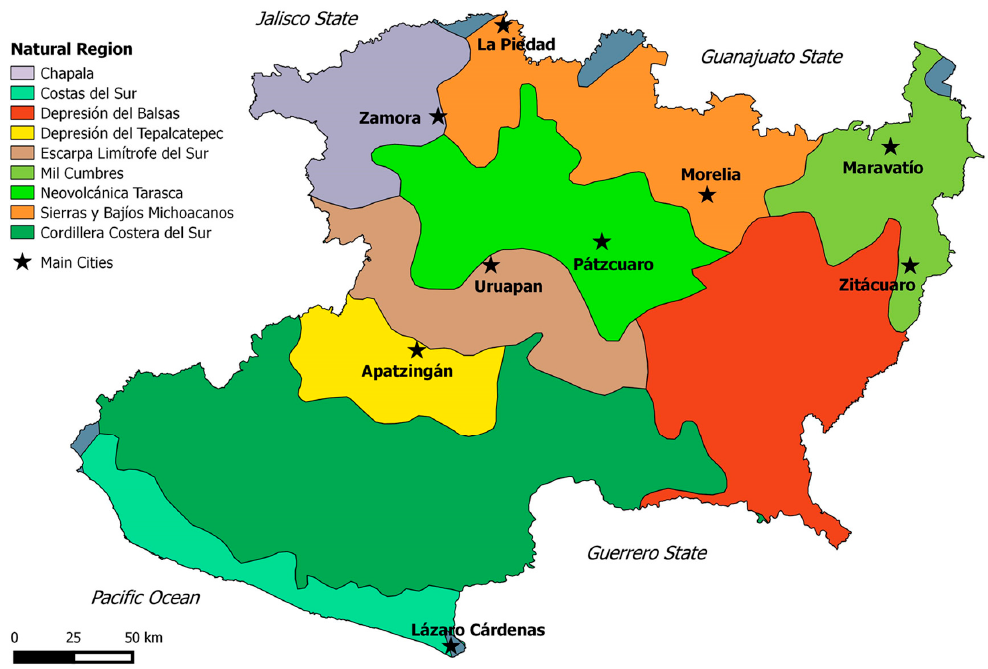
Figure 1. Natural regions and main cities of the state of Michoacán [22].